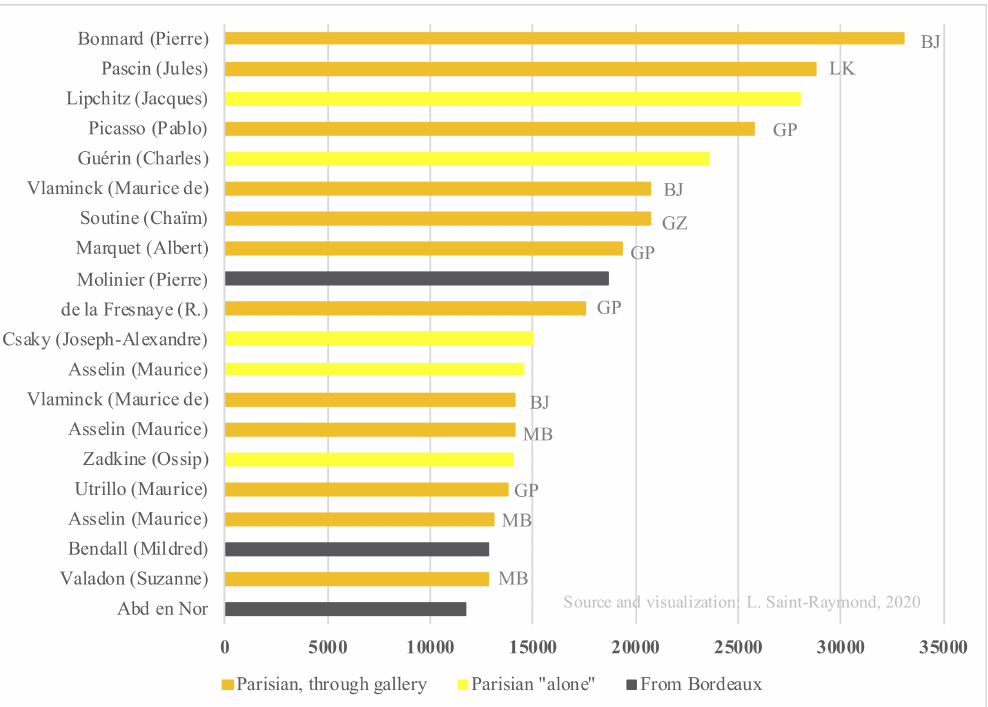
Figure 9. Most expensive artworks exhibited at the SAIB, sorted by their sale price in the catalogue, in constant 1928 francs. BJ stands for “Galerie Berheim Jeune”, GP for “Galerie de Paris”, GZ for “Galerie Zak”, LK for “Galerie Lucy Krohg” and MB for “Marcel